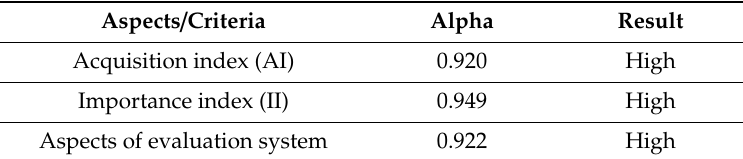
Table 2. The analysis of reliability (Cronbach α